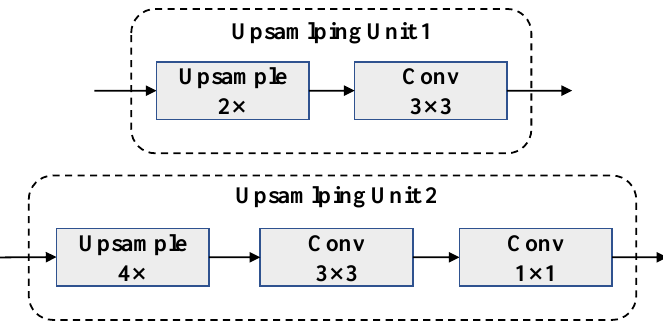
Figure 7. The structure of upsampling